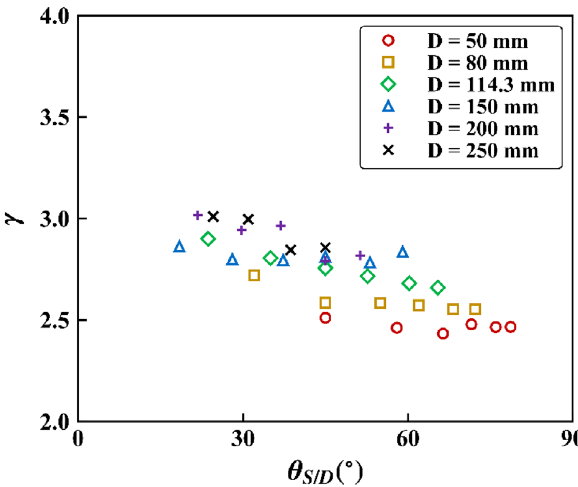
Figure 8. γ for various θ S / D and D